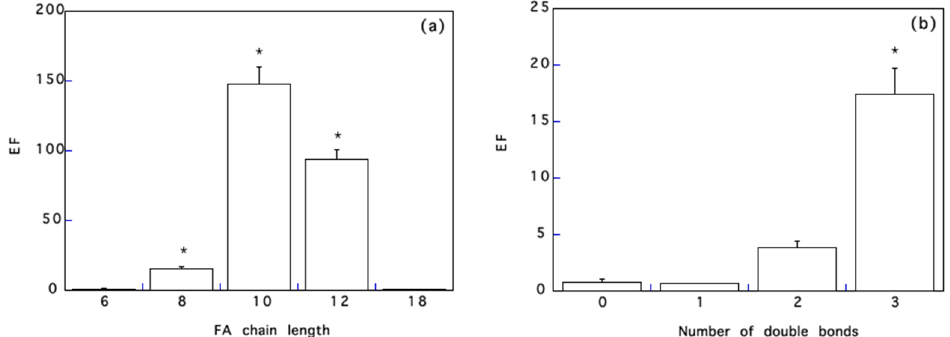
Figure 3. Panel ( a ) effect of fatty acid chain length (applied as pre-treatment at 10%) on FD-4 flux across pig esophageal epithelium. * significantly different among them and compared to the others. Panel ( b ) effect of the number of double bonds of C18 fatty acids (applied as pre-treatment at 10%) on FD-4 permeation across pig esophageal epithelium. * significantly different from the others. Mean values ± SEM.